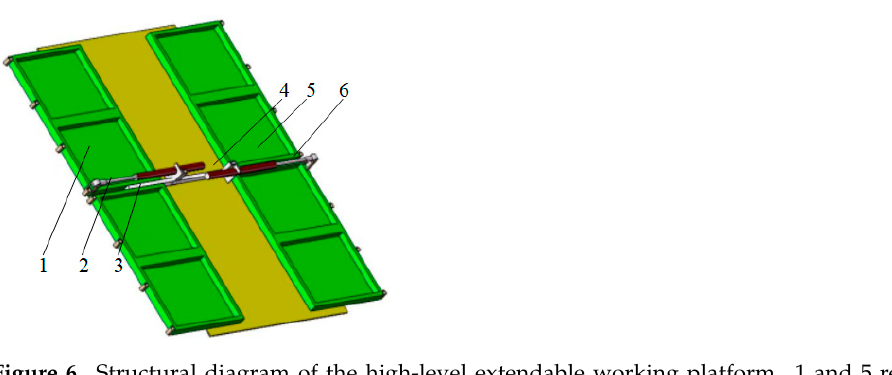
6 of 26 Figure 5. Schematic diagram of the hydraulic system of the extendable working platform and fruit box. 1 represents the hydraulic pump; 2 represents the unloading valve; 3, 4, 5, and 6 represent the solenoid directional valve; 7, 8, 11, and 12 represent the lifting hydraulic cylinders; 9 and 10 repre- sent the extension hydraulic cylinders. 2.2. Key Component Design 2.2.1. Design of High-Level Extendable Working Platform In order to facilitate operators to pick fruits at di ff erent heights and to meet the needs of multiple operators working at the same time, the platform has a double-sided, double- height, four-workstation design consisting of a high-level working platform and a low- level working platform. Since most fruits grow at the top of trees, the width of the high- level working platform is crucially important. A narrow high-level working platform would limit the working range of the operators, and frequent adjustments of the distance between the picking platform and the trees would greatly reduce work e ffi ciency. To im- prove the adaptability and e ffi ciency of the picking platform, a high-level working plat-